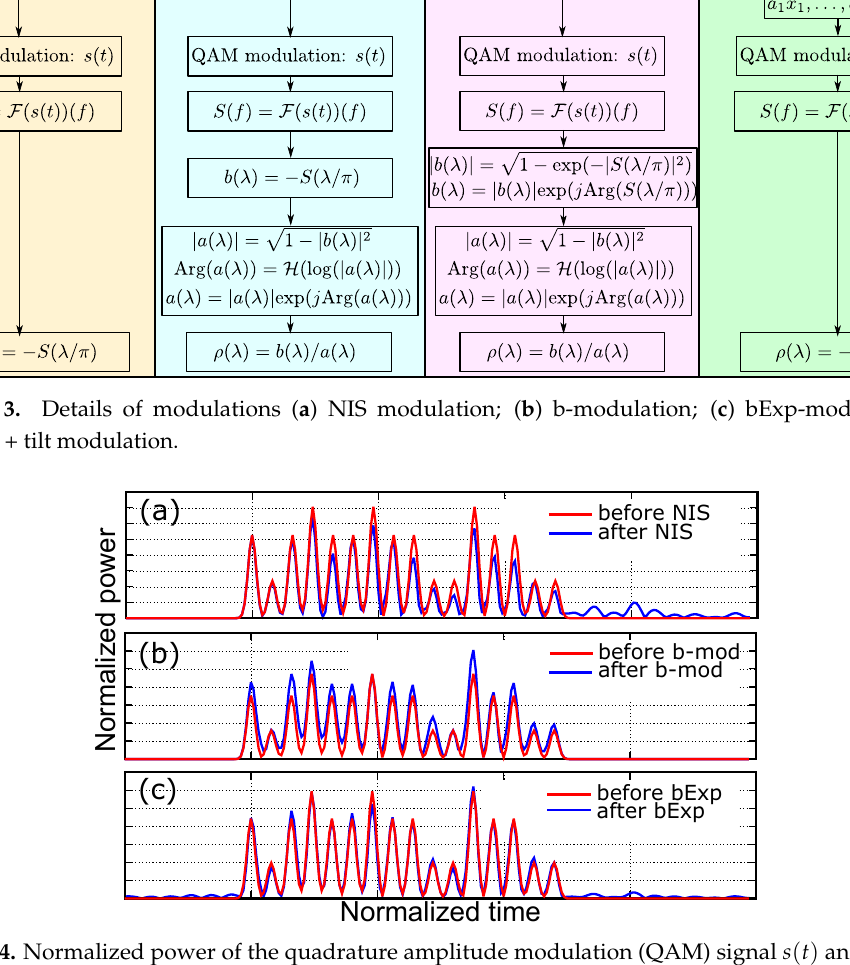
Figure 4. Normalized power of the quadrature amplitude modulation (QAM) signal s ( t ) and of the corresponding optical waveform q ( t ) for N b = 16 symbols and ( a ) NIS modulation; ( b ) b-modulation; ( c ) bExp-modulation. The waveform power is